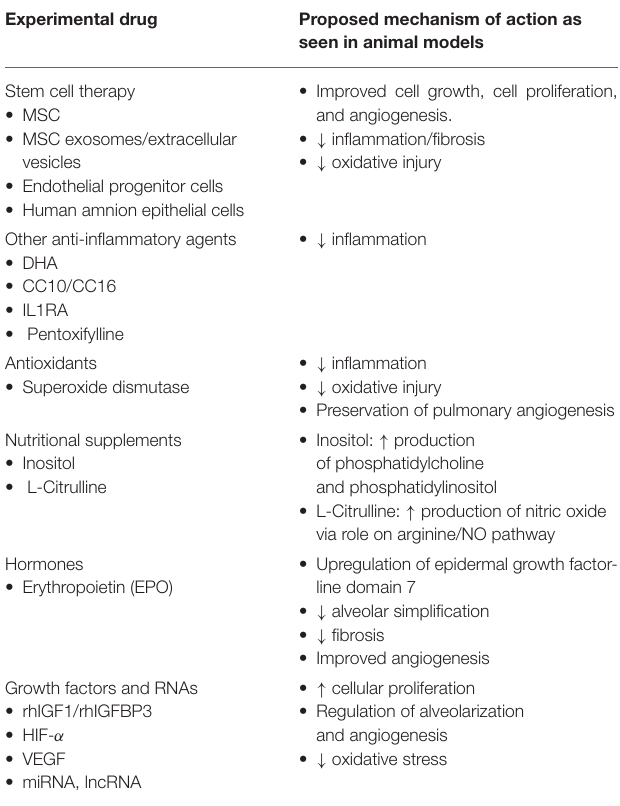
TABLE 3 | New experimental drugs for BPD. Experimental drug Proposed mechanism of action as seen in animal